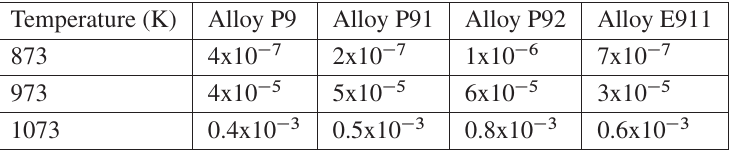
Table 2. Parabolic rate constants (Kp) in air (mg 2 mm (cid:3) 4 h (cid:3) 1